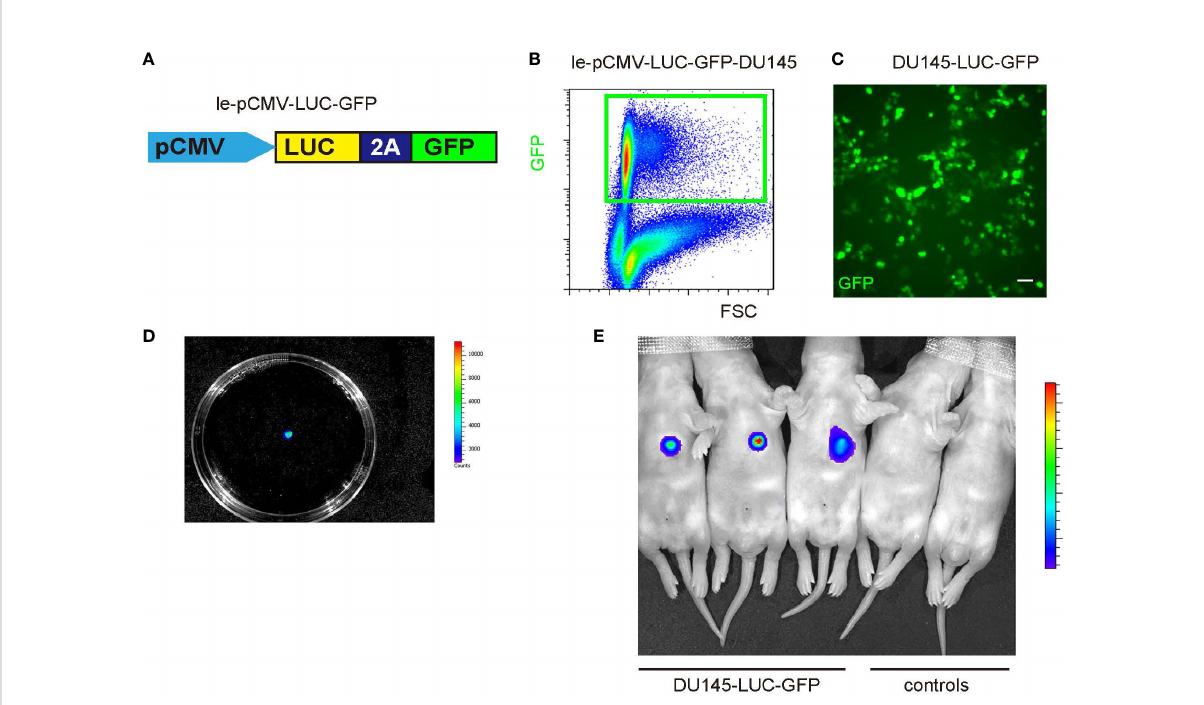
FIGURE 2 Establishment of a mouse PrC model (A) A diagram of a lenti vector carrying a luciferase and a green fl uorescent protein (GFP) reporter under a CMV promoter. (B) The lenti-pCMV-LUC-GFP was used to transduce DU145 cells, sorted by fl ow cytometry as GFP-positive cells. (C)